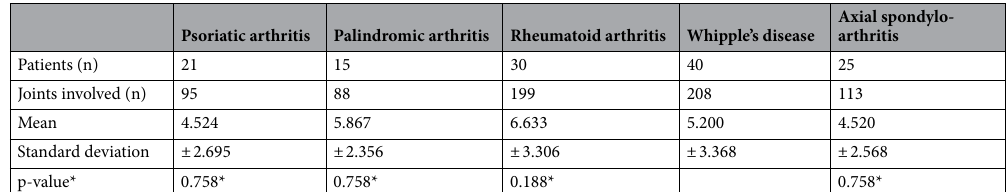
Table 2. Number of painful joints in patients with psoriatic-, palindromic-, rheumatoid-, and axial spondyloarthritis compared to the initial 40 patients with Whipple’s disease. *One-way ANOVA followed by Holm-Sidak´s multiple comparison tests vs. Whipple’s disease